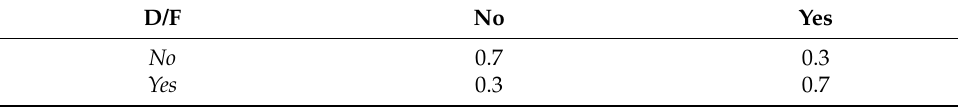
Table 2. Conditional Probability P(D /F ) [26].